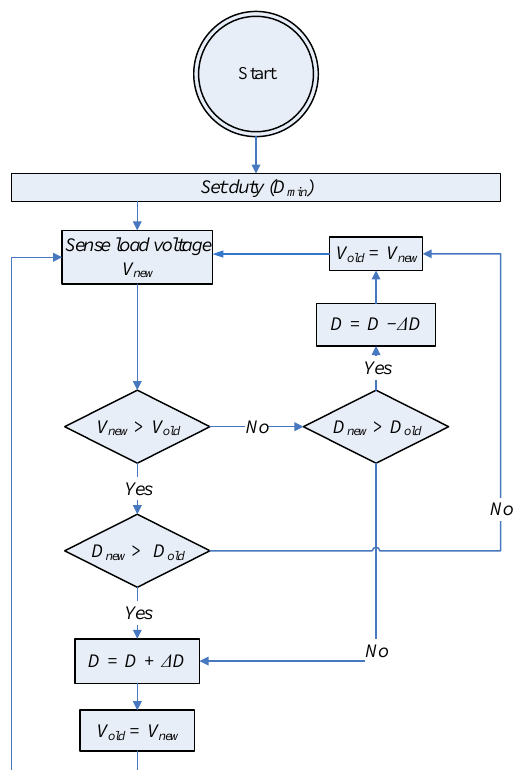
Figure 8. Flow chart of proposed MPPT algorithm.